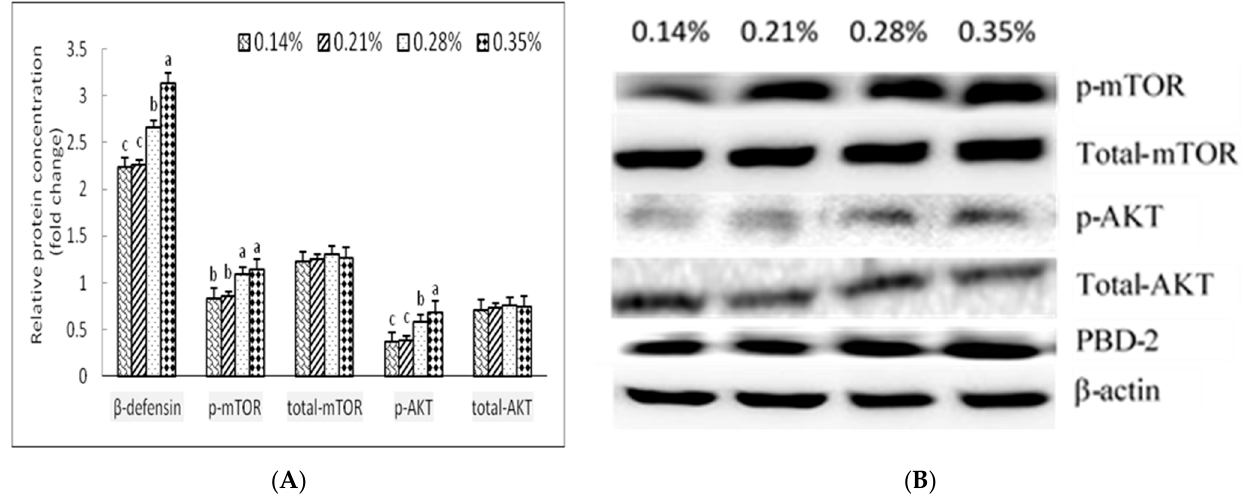
Figure 2. Effects of dietary tryptophan levels on the relative protein concentrations of p-mTOR, mTOR, p-AKT, AKT, and PBD-2 in the colon mucosa of weaned piglets ( n = 5). ( A ) The results of western blot analysis. ( B ) Western blot figure. a, b, c: values with different letter superscripts within the same index mean significant differences ( p < 0.05). All data are mean ± SEM. Abbreviations: p-mTOR, phosphorylated mammal target of rapamycin; p-AKT, phosphorylated protein kinase B; PBD-2, β -defensin 2.